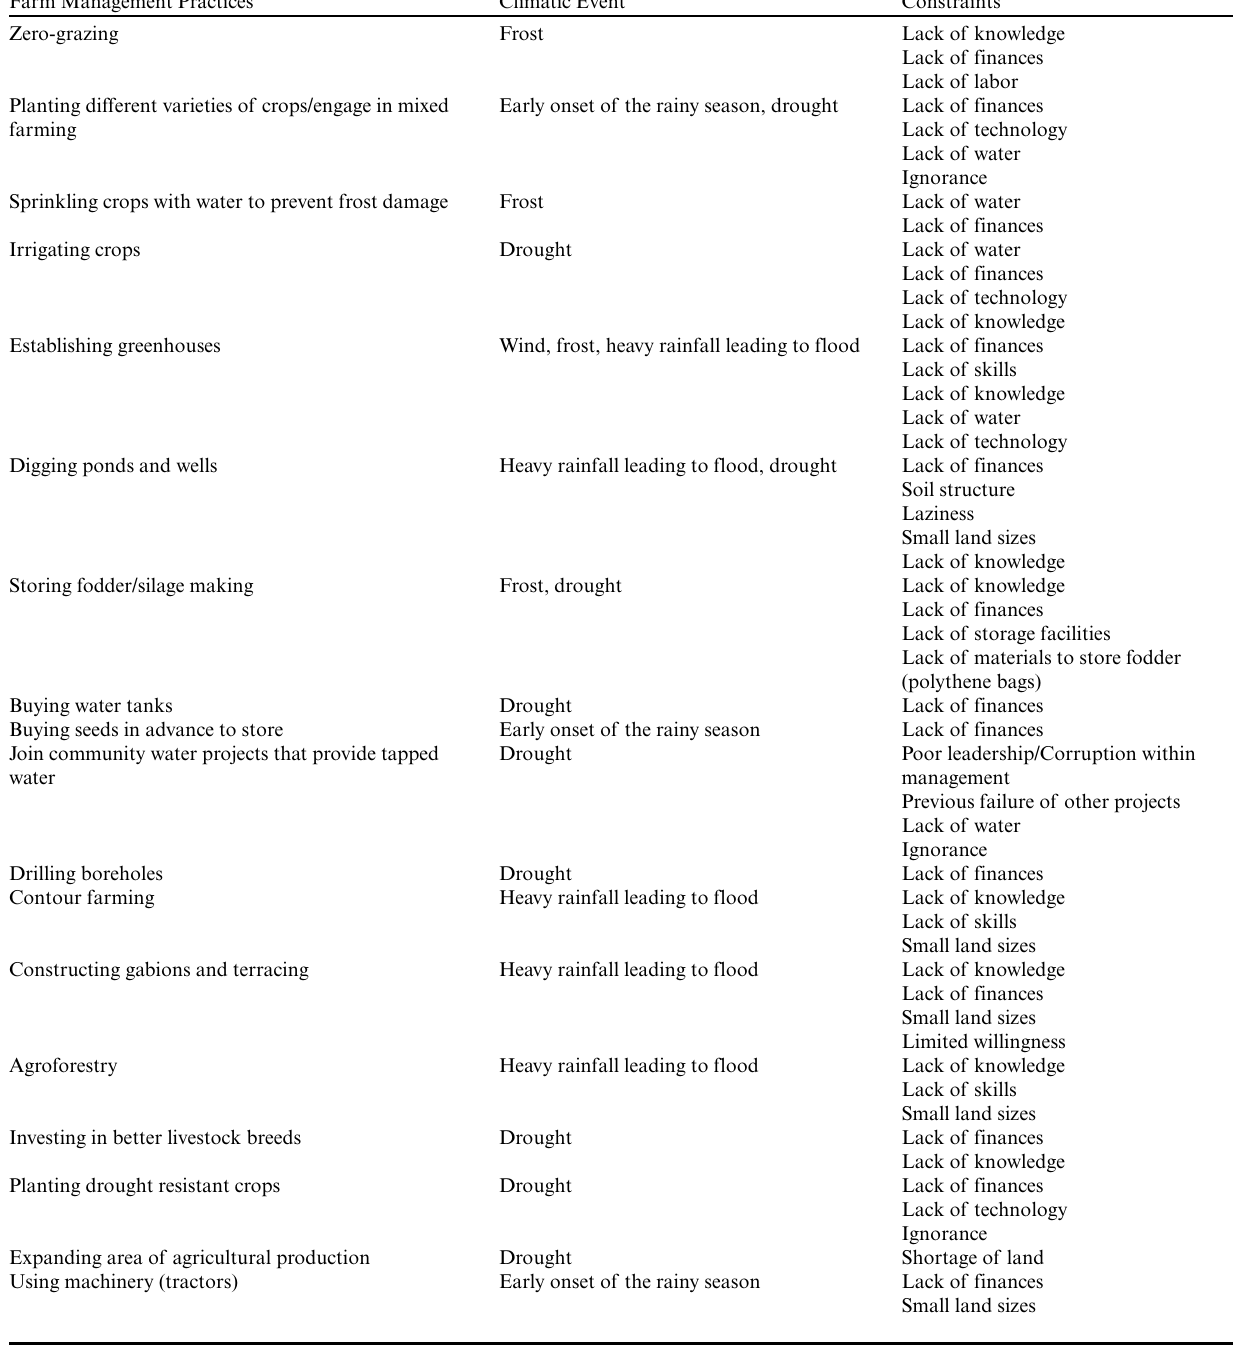
Table 3 . Farm management practices known to farmers to deal with climate variability and extremes, but which are not yet widely